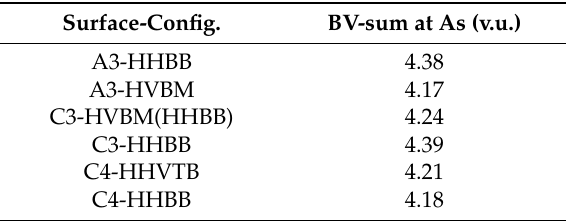
Table 3. Calculated BV sums for As, as adsorbed onto different surfaces.